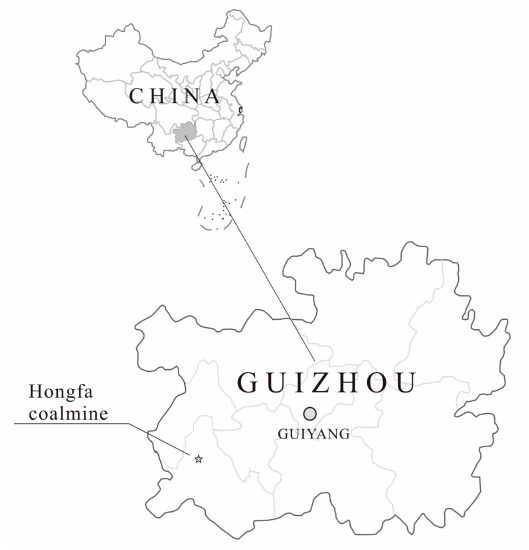
Figure 1. The location of the Hongfa coalmine, southwestern Guizhou,